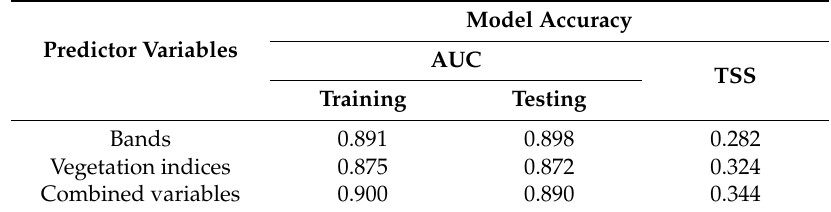
Table 4. Evaluation results for all Maxent models used for predicting the probability of the occurrence of C. tristis